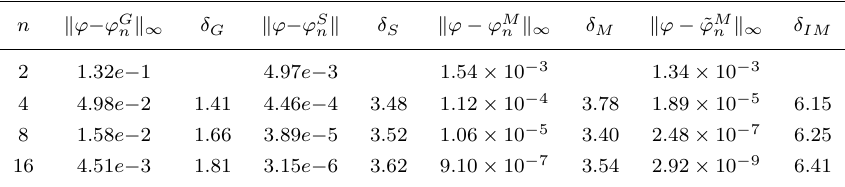
Table 2. Piecewise linear